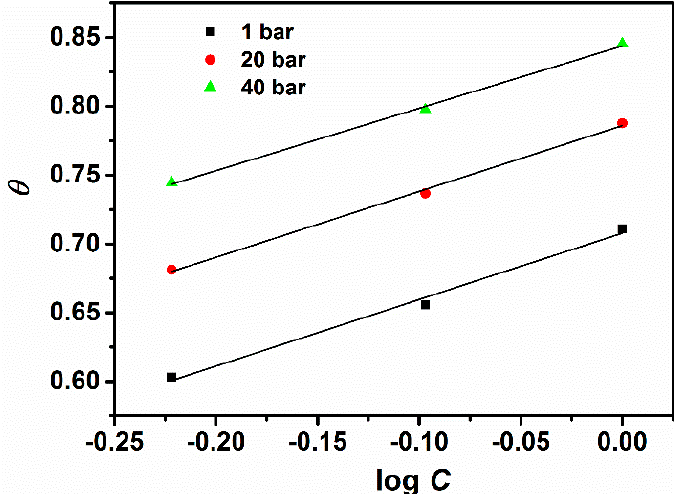
Figure 6. Temkin’s adsorption isotherm for carbon steel (N80) pipeline steel in CO 2 -saturated chloride at different pressures.